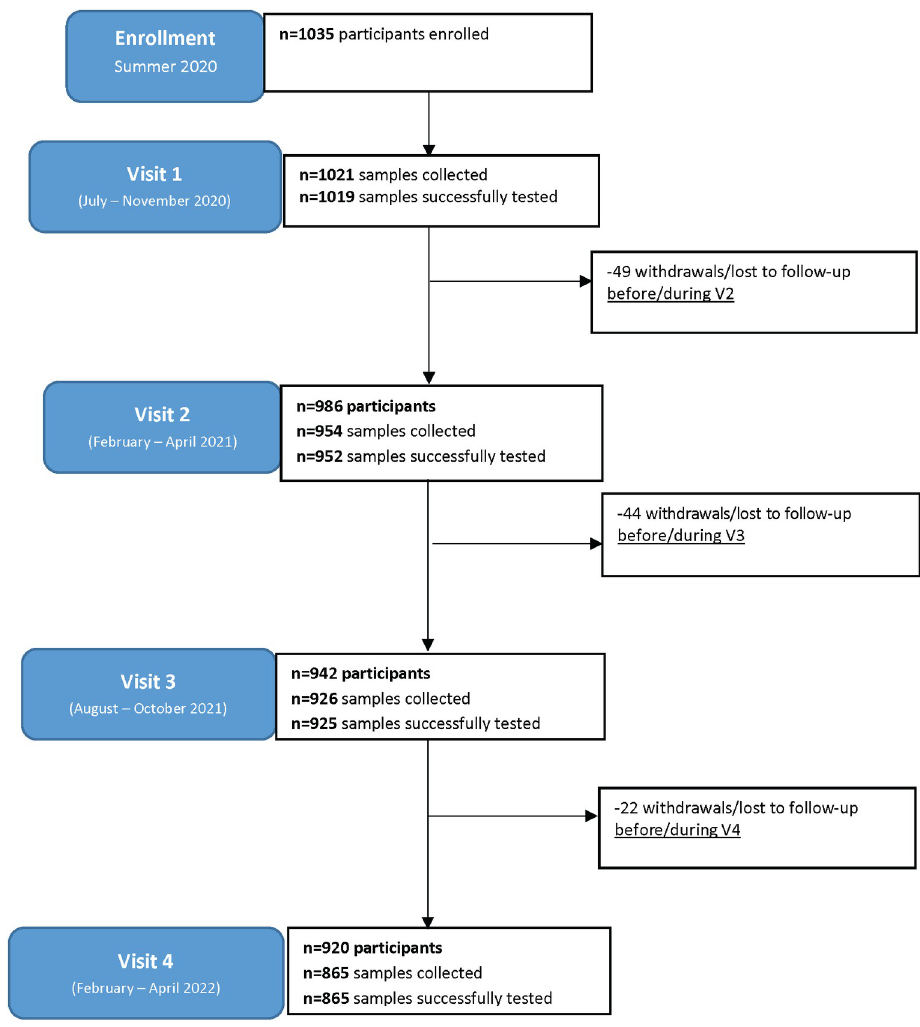
Fig 1. Study participation flow